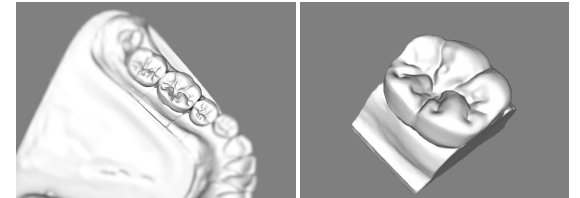
Figure 4. Wax crown scan on stone casts of dental lower arch and separate tooth